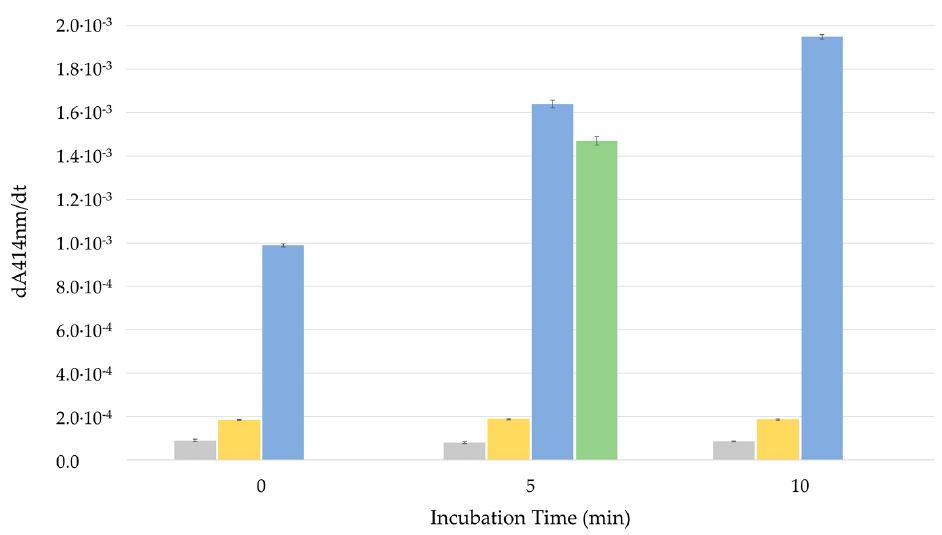
Figure 7. Enzymatic activity time dependence in four different systems: (grey bar) Blank vesicles with HRPC entrapped without peptides (dilution factor 100 × ); (green bar) control vesicles with HRPC entrapped, adding Triton X-100 (dilution factor 2000 × ); (yellow bar) vesicles with HRPC entrapped, adding a solution of ALY at 4 µ M (dilution factor 100 × ); and (blue bar) vesicles with HRPC entrapped, adding a solution of azoALY at 4 µ M (dilution factor 100 × ). Each data point shown is the average from three measurements and the small standard deviation is indicated with a bar.